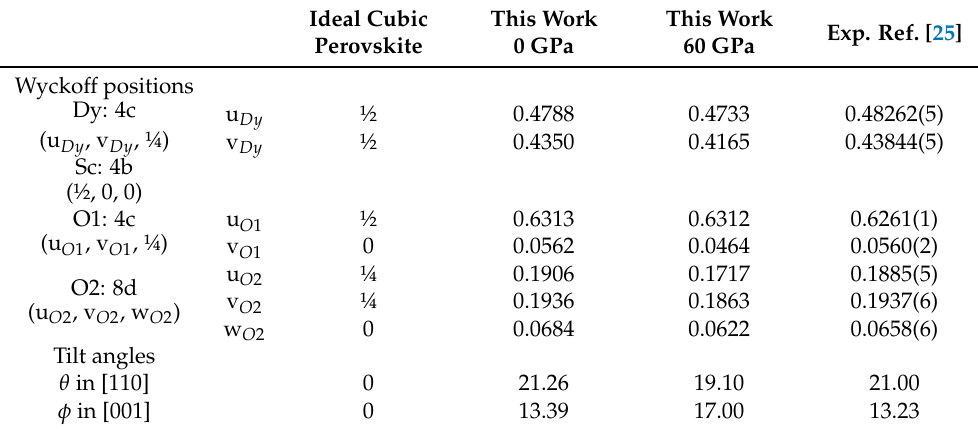
Table 3. Summary of the atomic sites of DyScO 3 perovskite, showing the values of the internal parameters and tilt angles. The values for the ideal cubic perovskite structure are also provided, for reference.